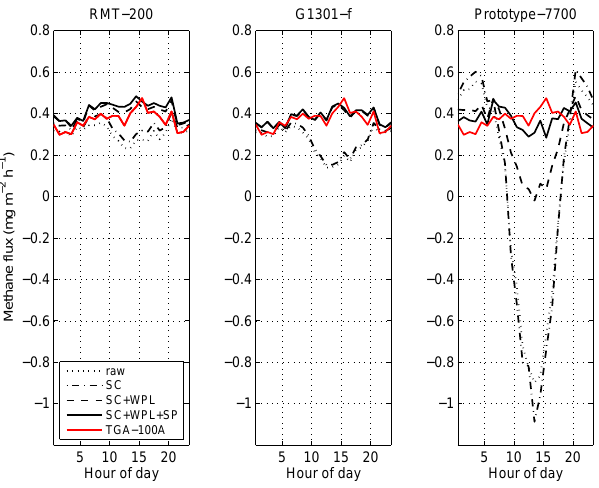
Fig. 6. Transfer function determined from measured cospectra. Grey line is transfer function (Eq. 4), black dots connected with a line rep- resents mean methane cospectrum ( S w c ) divided with mean tem- perature cospectrum ( S wT ), grey dots show individual methane cospectra divided with corresponding temperature cospectra. Re- sponse times related to each gas analyzer are shown in the figure. Cospectral data was binned into 35 logarithmically evenly spaced bins before plotting. For Prototype-7700 data were selected from a period 17 May–17 April using the same selection criteria as in Sect. 3.2, while for the other gas analyzers data were selected from a period 9–29 June.